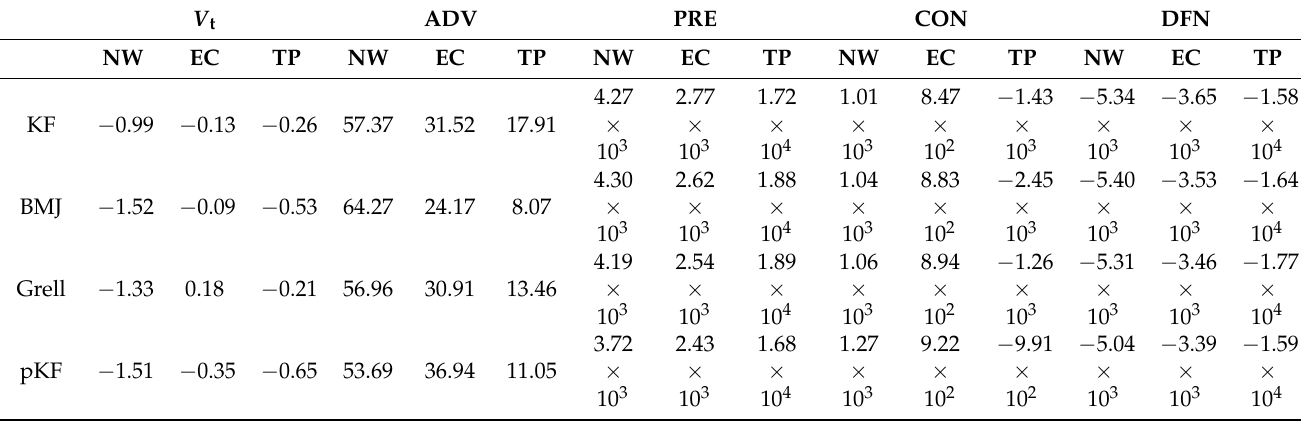
Table 2. Different CPS-ensemble area-averaged summer mean integral results of the five terms in Equation (1) (units: m s − 1